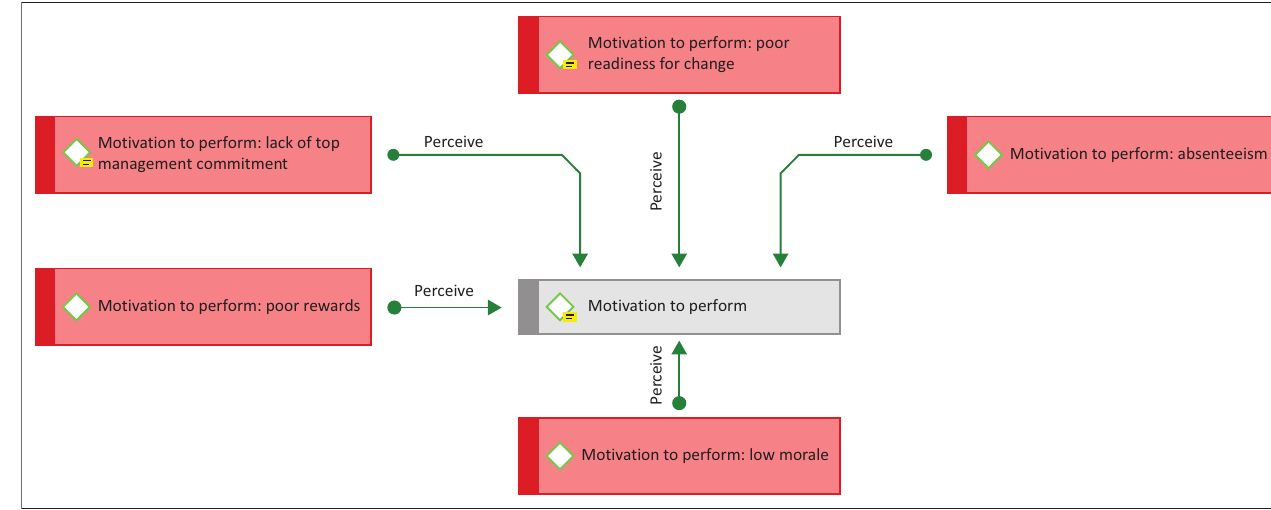
FIGURE 1: Code network for the theme employee